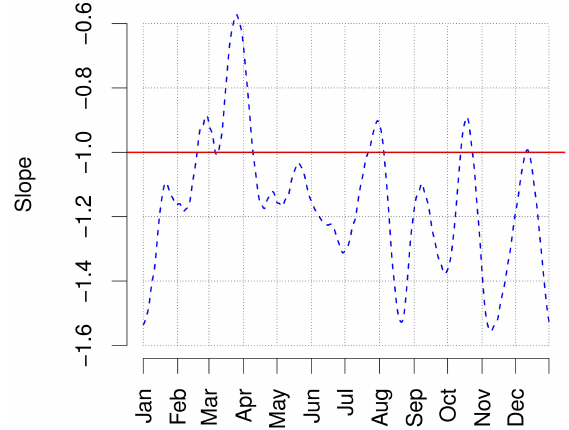
Fig. 9. Analysis of the inter-annual variance for the time series of the Po River at Pontelagoscuro